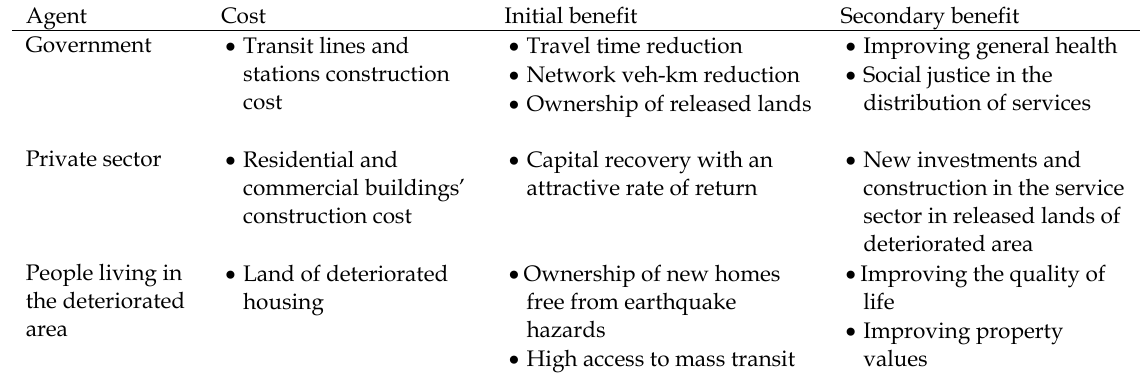
The structure of the proposed method The benefits and costs of TOD implication for